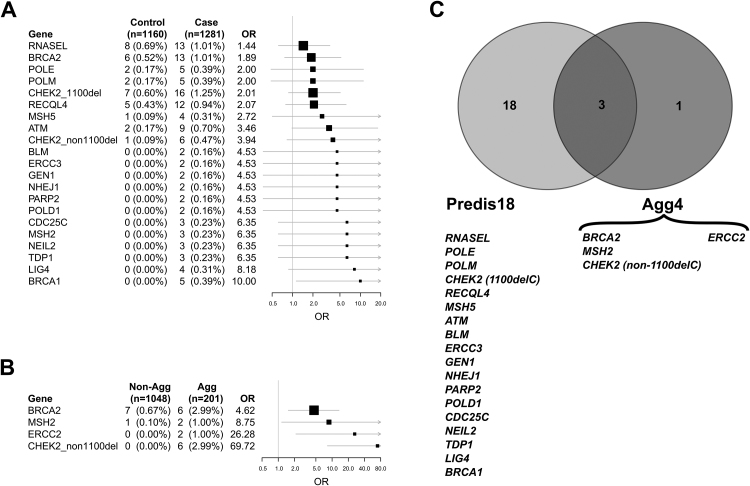
Gene set selection. Forest plots of (A) 20 unique genes selected by ADA case–control analysis and (B) four genes selected by ADA aggressive phenotype analysis. Odds ratios (ORs) were estimated from the collapsed tier 1 MAF <0.5% variant count using unadjusted Firth's logistic regression, with 0.5 added to each count to provide estimates for genes with no carriers in one cohort. (C) Intersection of gene sets from the case-control and aggressiveness analyses and partition into non overlapping Predis18 and Agg4 gene panels. ADA = adaptive combination of p values; MAF = minor allele frequency.